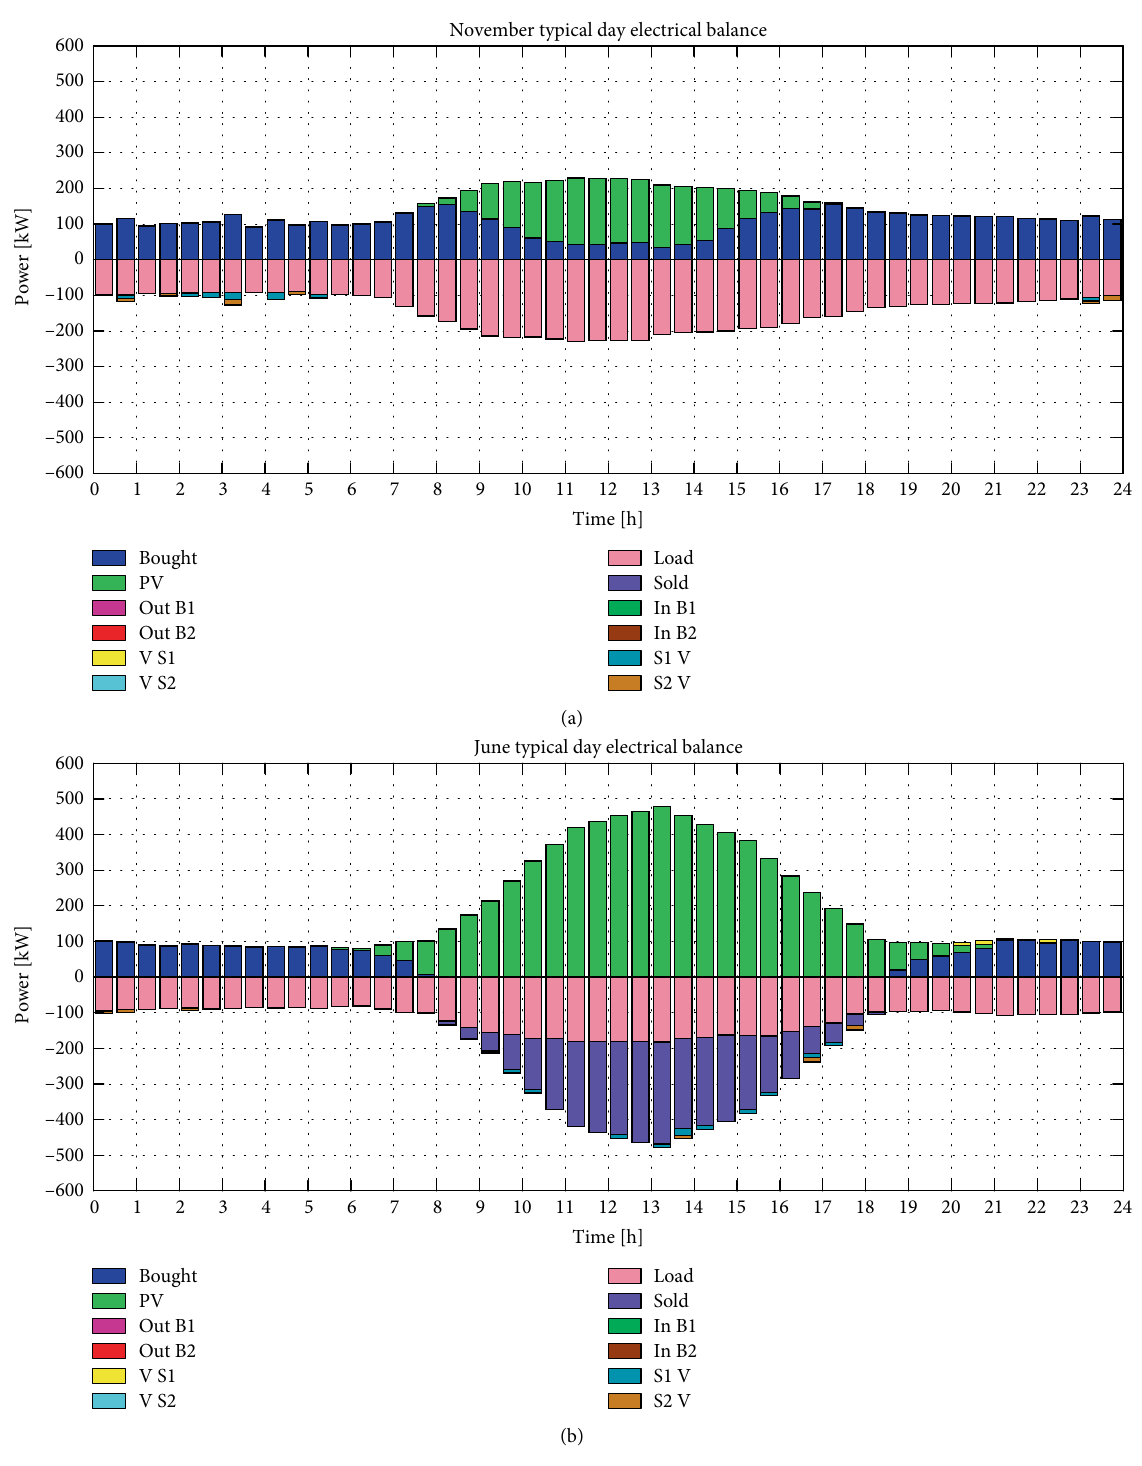
Figure 5: (a) November day electrical profiles for Case 4.1. (b) June day electrical profiles for Case